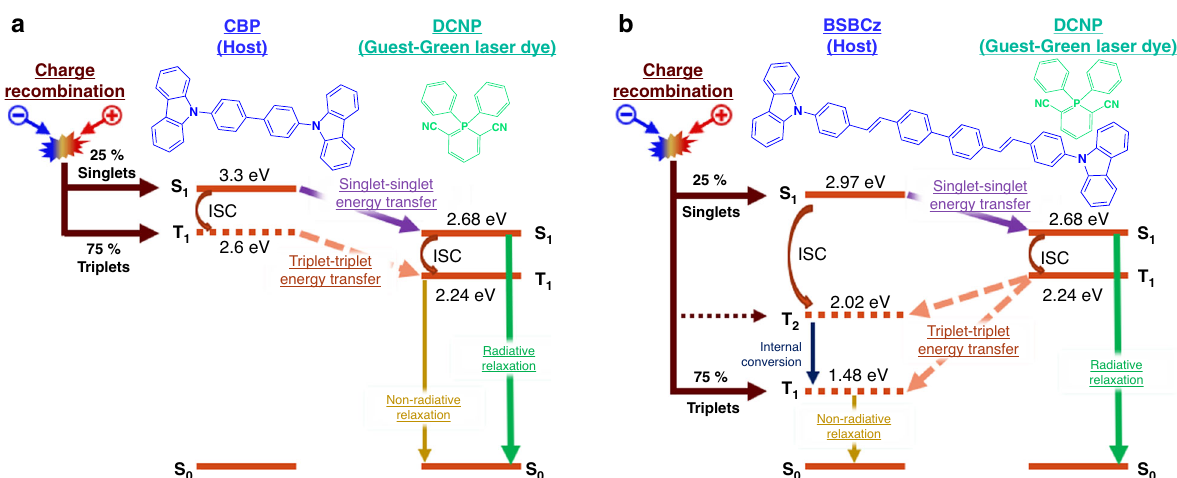
Fig. 1 Energy level diagram of guest – host systems. Energy transfer processes under electrical excitation when the guest material is DCNP and the host material is a CBP or b BSBCz. Chemical structure of each material is given with its abbreviated name. S 0 , S 1 , T 1 , T 2 , and ISC stand for the singlet ground state, the fi rst singlet excited state, the fi rst triplet excited state, the second triplet excited states, and the intersystem crossing, respectively. The triplet excited-state energies of BSBCz were taken from literature 18 . The other excited-state energies of CBP, DCNP, and BSBCz were estimated from the onset wavelengths of fl uorescence spectra at room temperature and phosphorescence spectra at 77